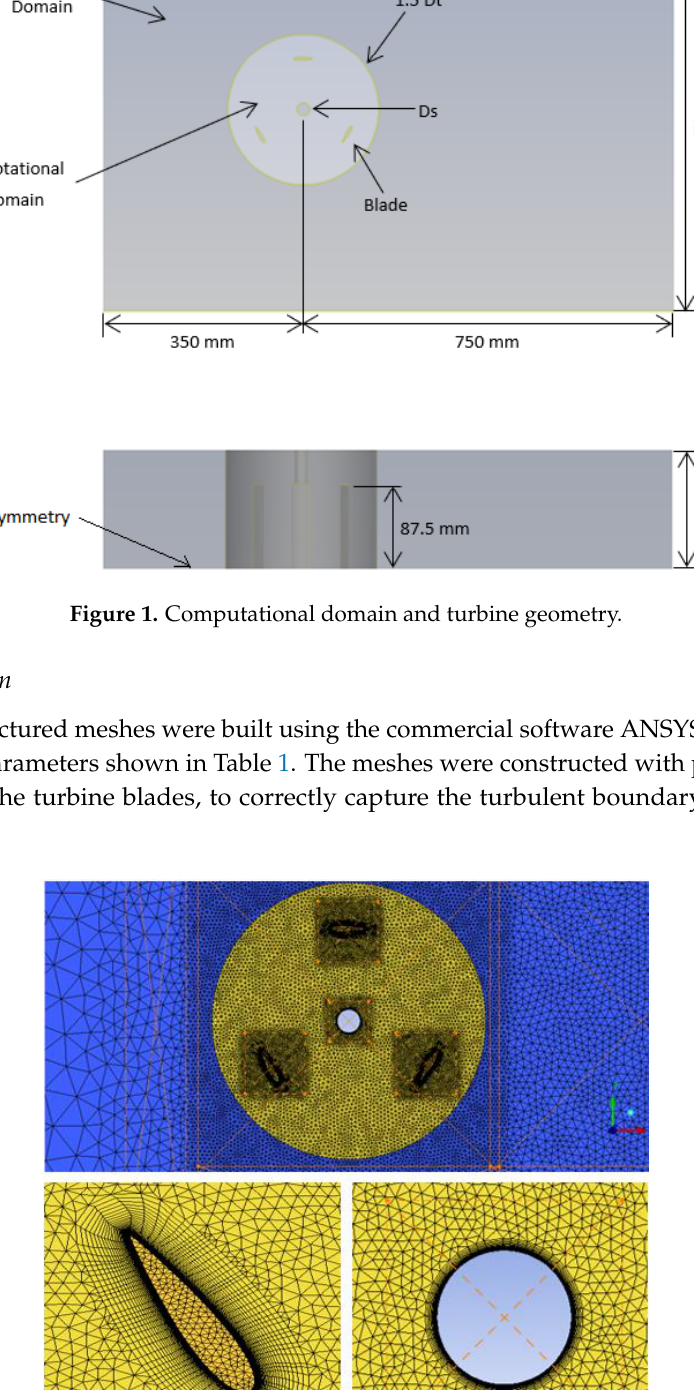
Figure 3. Fine mesh with density box detail. 3.3. URANS k-ω SST Simulation Set-Up The commercial software ANSYS-FLUENT v17 was used for the present work. Regarding boundary conditions (see Figure 4) on the velocity inlet was assigned a velocity of 2.8 m/s and a turbulence intensity of 2% which correspond to the values originally used by Amet [12]. It is important to mention that no experimental measurements are reported of the turbulence intensity for the water tunnel used at LEGI.